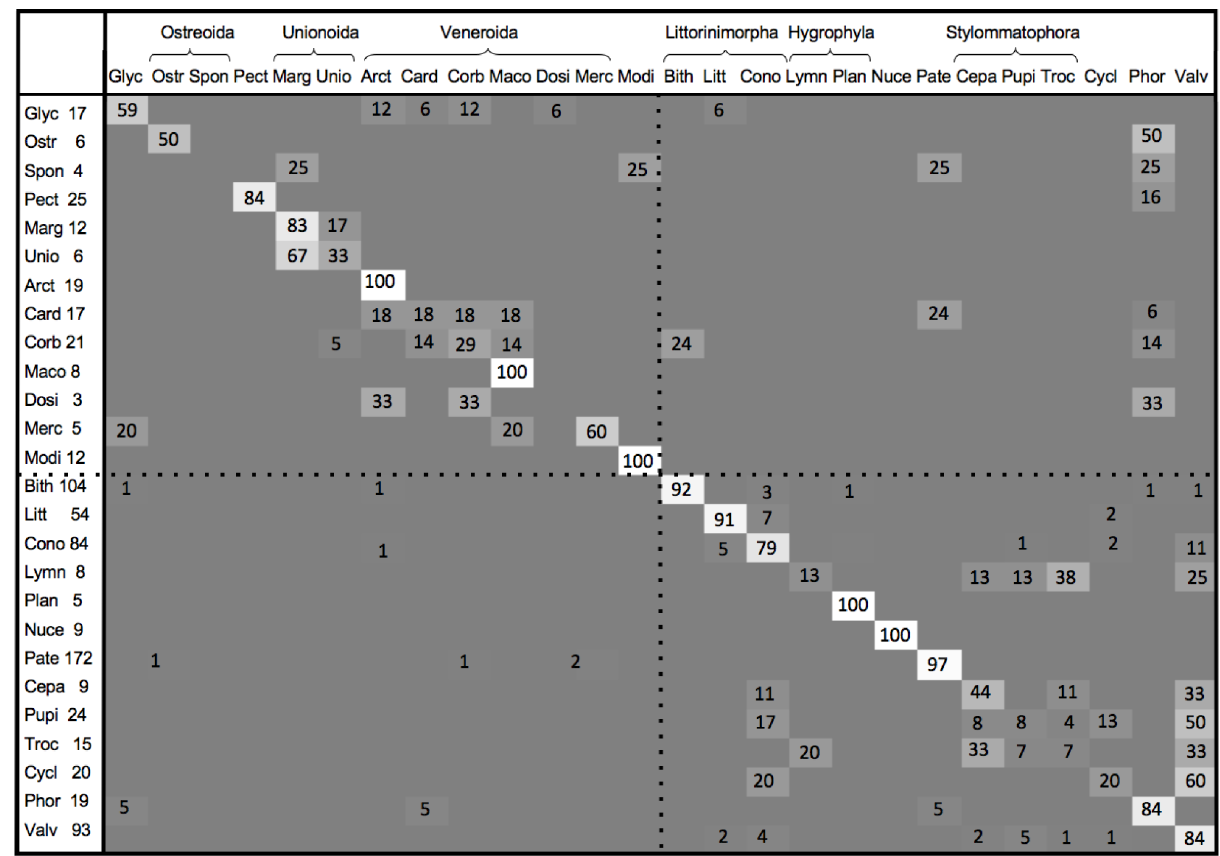
Figure 3. Classification results. Results of the classification performed using Learning Vector Quantization. Leave-one-out (L-O-O) classification was used for validation and the results show how the test samples were classified. Each row represents one of the 26 genera included in the analysis, as indicated on the left of the table together with the number of examples tested. The four-letter codes uniquely identify each genus (full names in Table 1). The columns show the predicted genera. Numerical values are percentages so that the element in column i of row j shows the percentage of genus j that were classified as genus i and the main diagonal shows the percentage of each genus correctly classified. The dotted lines separate Bivalvia from Gastropoda and brackets above the predicted class names group genera within the same order. The grey-scale intensities are related to the numerical values with white corresponding to 100% and the darkest grey to 0% (for which no numerical value is given). Note that rounding may result in rows not summing to 100%.